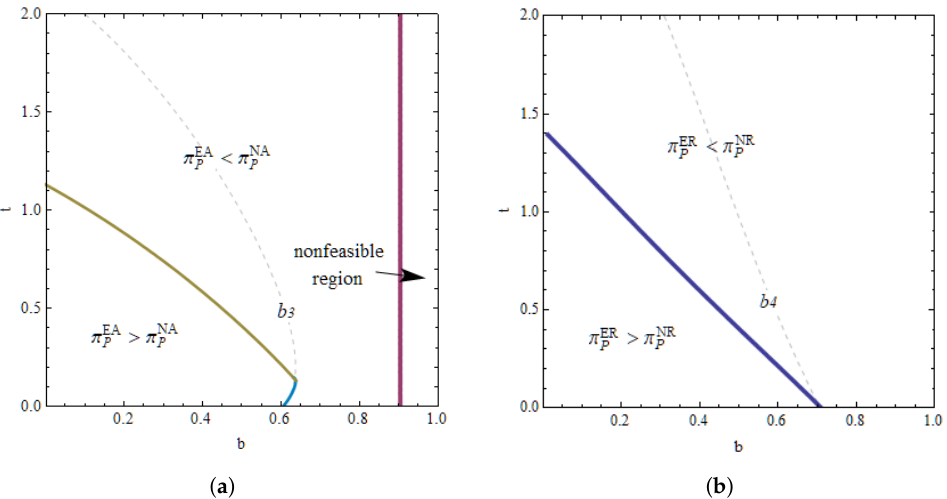
Figure 3. The profit change of the platform ( a = 0.5, r = 0.2, c = 0.1). ( a ) under the agency mode. ( b ) under the reselling